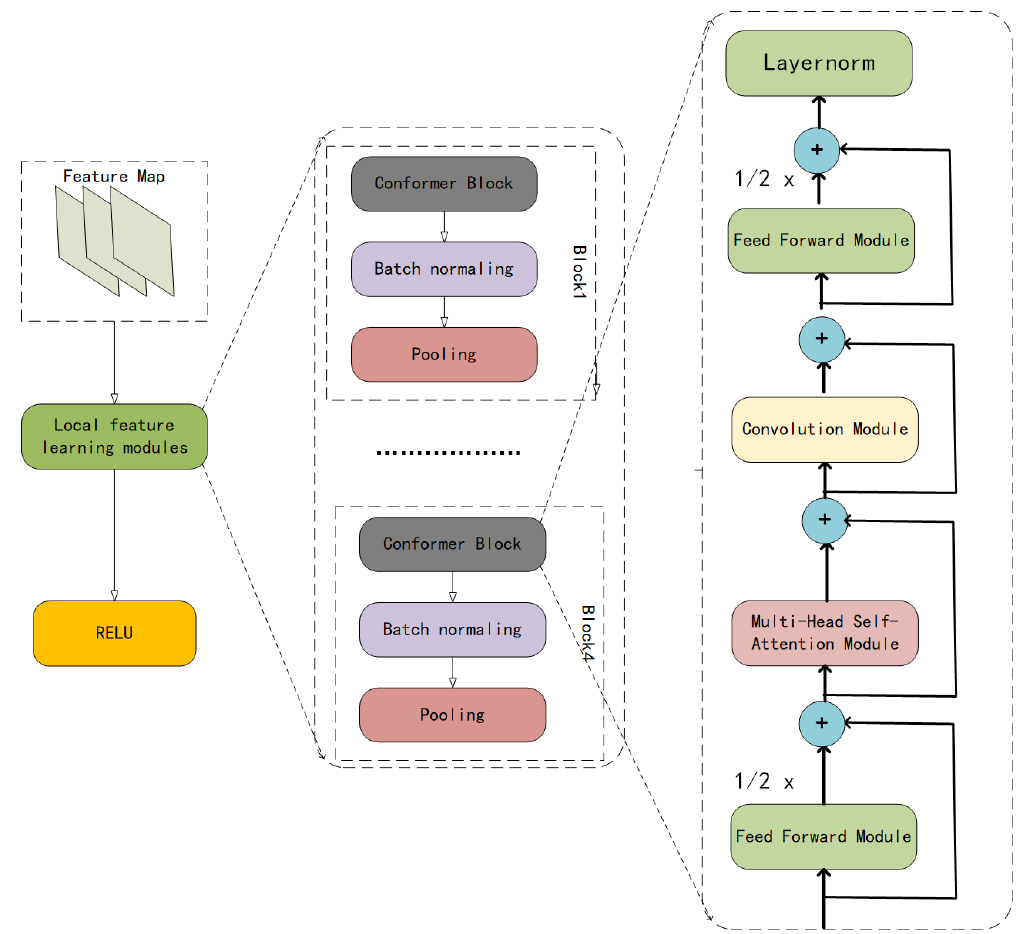
Figure 3. Framework diagram of local feature learning